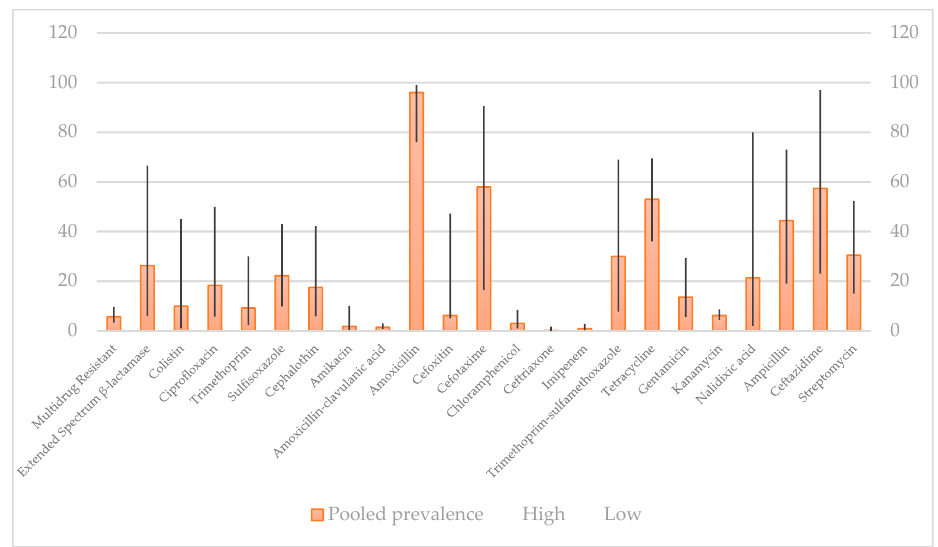
Figure 3. Pooled prevalence of antibiotic resistance isolates in pet animals by disk diffusion method, % [161].